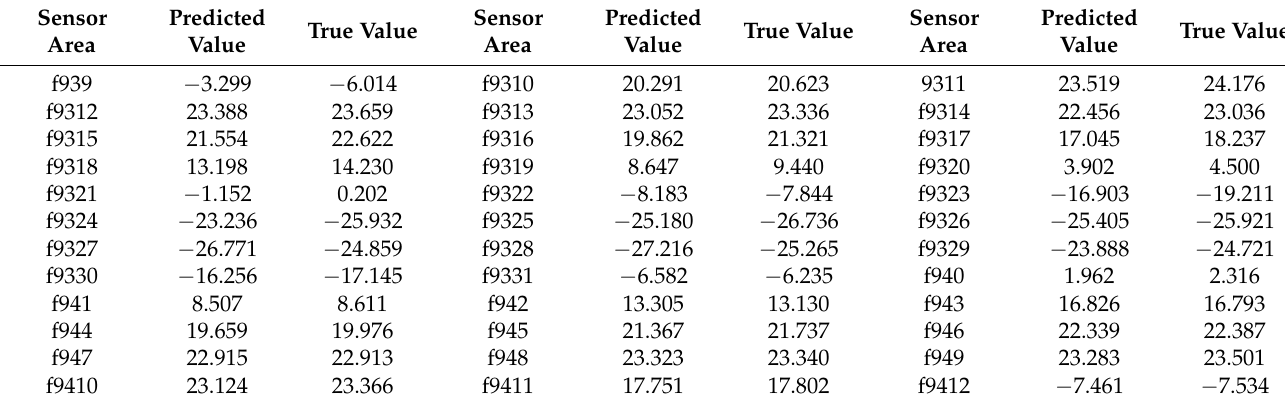
Table 3. Comparison of real and predicted values.